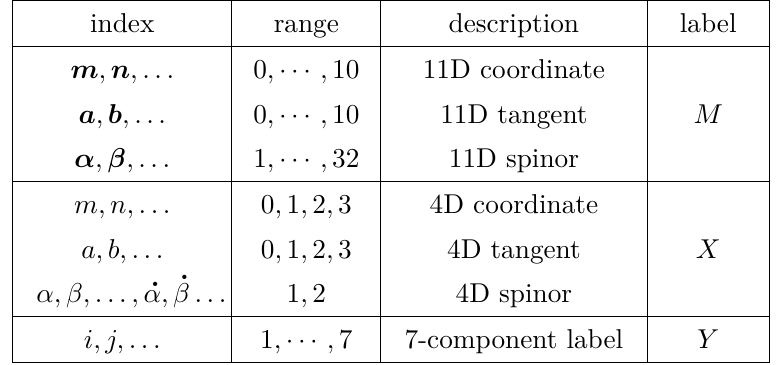
Table 2 . Legend of indices used in this work. To avoid having even more indices, those in the various 7 -dimensional representations ( GL(7) coordinate, SO(7) tangent, G label for seven gravitini), have all been